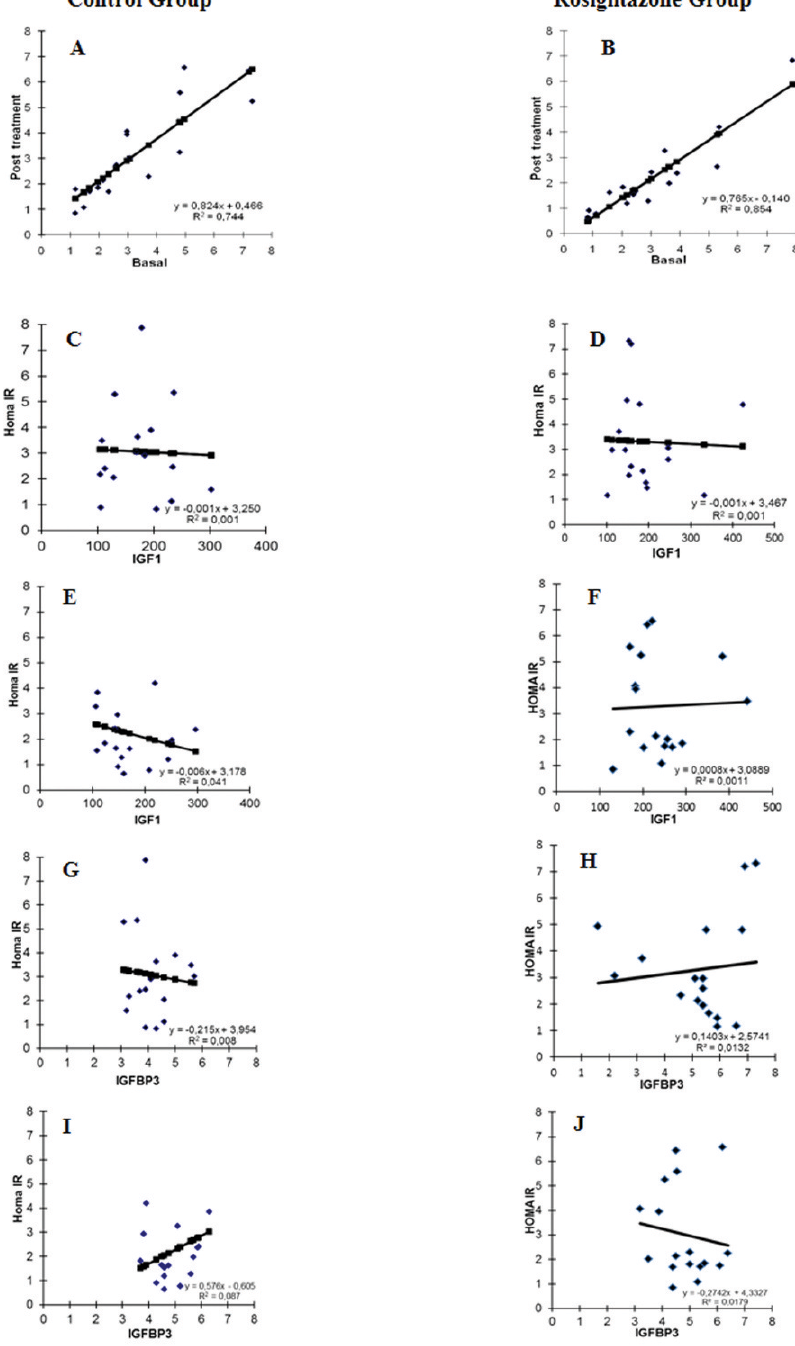
Figure 2 - Pearson’s correlation between insulin resistance and IGF-1 and IGFPB-3. A – Correlation of HOMA-IR values before vs. after treatment in the control group; B - Correlation of HOMA-IR values before vs. after treatment in the rosiglitazone group; C – Correlation of HOMA-IR values with IGF-1 levels before treatment in the control group; D - Correlation of HOMA-IR and IGF-1 levels before treatment in the rosiglitazone group; E - Correlation of HOMA-IR values with IGF-1 levels after treatment in the control group; F - Correlation of HOMA-IR values with IGF-1 levels after treatment in the rosiglitazone group; G - Correlation of HOMA-IR values with IGFPB-3 levels before treatment in the control group; H - Correlation of HOMA-IR values with IGFPB-3 levels before treatment in the rosiglitazone group; I - Correlation of HOMA-IR values with IGFPB-3 levels after treatment in the control group; J - Correlation of HOMA-IR values with IGFPB-3 levels after treatment in the rosiglitazone resistance and decreased IFG-1 and IFGBP-3 levels. We also because the hair follicle cycle ranges from six months to two observed a decrease in the free testosterone fraction and an years (6,22), thus requiring a more prolonged treatment to increase in SHBG. Hirsutism was not evaluated in this study observe any changes than was possible in the time frame of